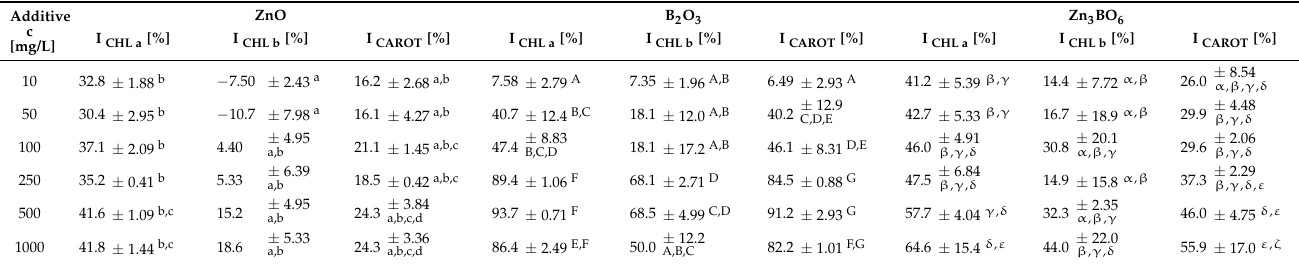
Figure 3. Chlorophyll b content in L. minor plants after 7 days of growth in the solutions supplemented with ZnO, B 2 O 3 or Zn 3 BO 6 , respectively, at concentrations of 10, 50, 100, 250, 500 and 1000 mg/L. Control plants grew in Steinberg solution; standard deviation is represented as ± S.D. ( n = 3), and two-way ANOVA test with Dunnett’s multiple comparisons was applied. Table 2. The change in chlorophyll a and b content (calculated as a percentual inhibition of chlorophyll synthesis compared to control) in L. minor plants after 7 days of growth in the solutions supplemented with ZnO, B 2 O 3 or Zn 3 BO 6 , respectively, at concentrations of 10, 50, 100, 250, 500 and 1000 mg/L. Control plants grew in Steinberg solution; standard deviation is represented as ± S.D. ( n = 3), and two-way ANOVA test with Dunnett’s multiple comparisons was applied. B 2 O 3 Zn 3 BO 6